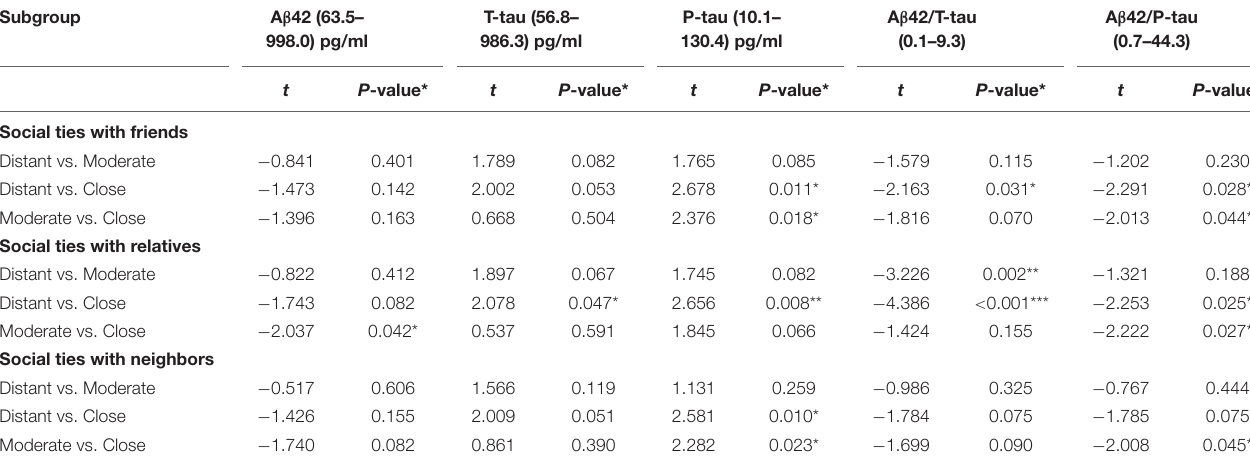
TABLE 3 | Three subgroups of social network and CSF biomarkers. Subgroup